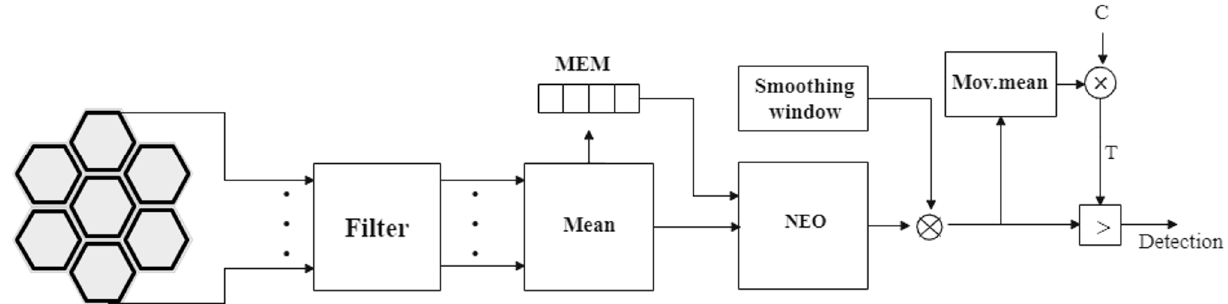
Figure 4. SNEO block diagram. Signals from the seven channels are filtered and averaged, to exploit the correlation between data captured by adjacent pixels. The memory block (MEM) stores the samples needed to compute the nonlinear energy operator (NEO). Then, threshold T is a scaled version of the mean of the filtered NEO.